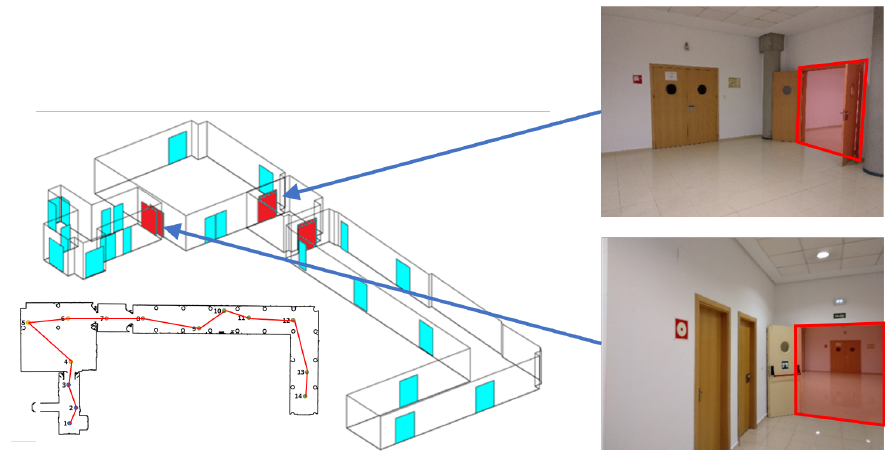
Figure 16. (Left) B-rep model generated by our system with traversed doors in red. The blueprint of the scene and the trajectory followed by MoPAD is shown below. (Right) Pictures taken from MoPAD and the recognized open doors highlighted in red.